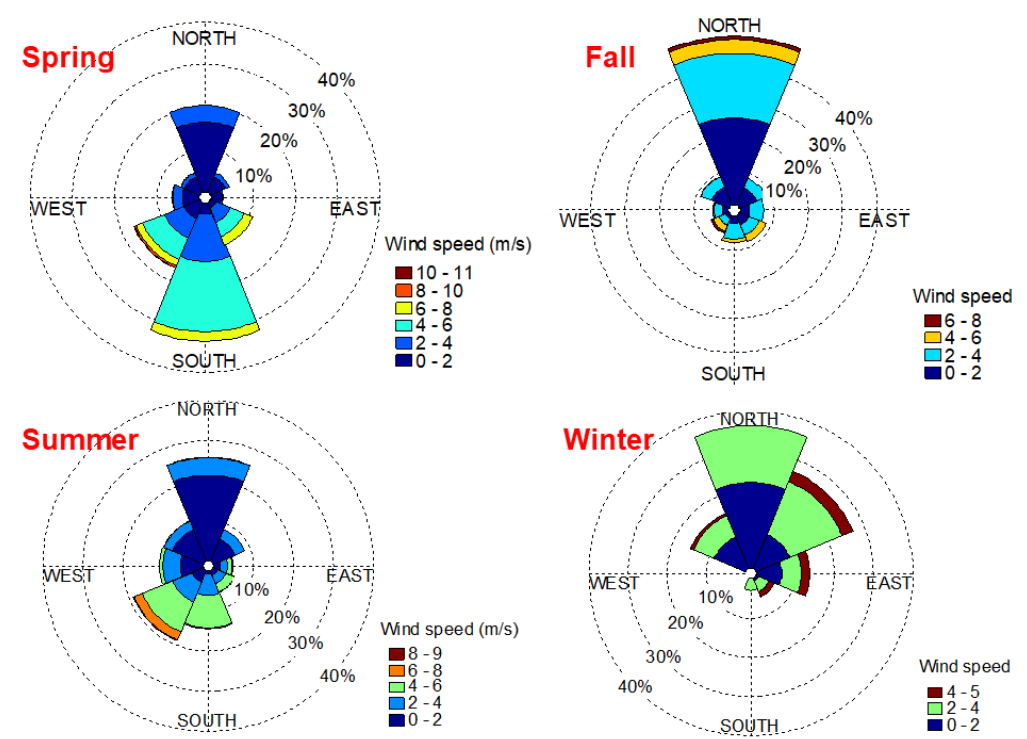
Figure A2. Wind roses showing the relationship between wind speed and wind direction for each sampling period at Grand Bay. y = 2E-06x + 1.288 y = 0.0009x + 1.112